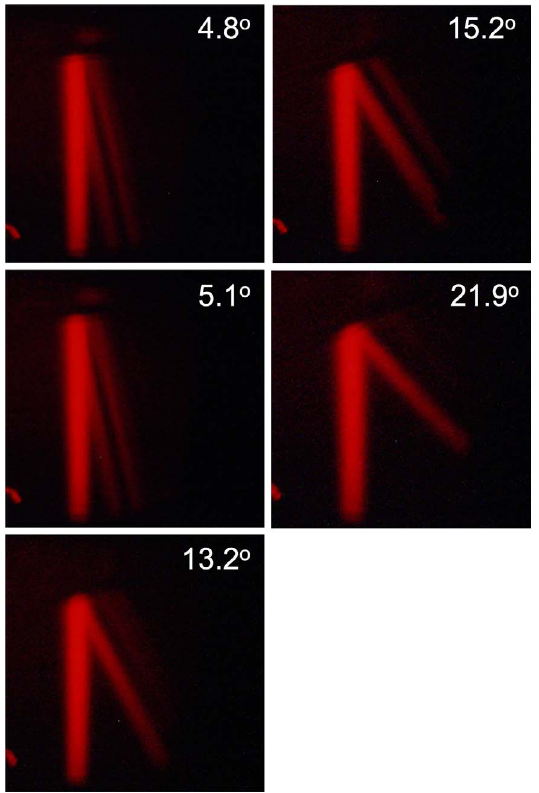
Figure 5. Schlieren photographs of Schoch effect on sample